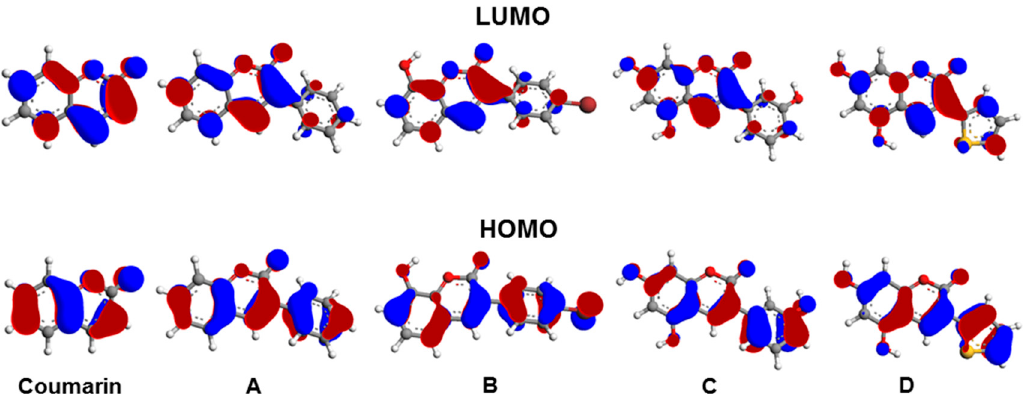
Figure 4. Frontier molecular orbitals of coumarin and molecules A – D calculated by density functional theory (DFT) at B3LYP / 6-31G* level of theory (contour plot 0.04).